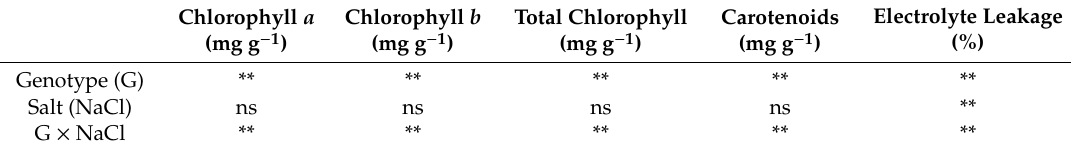
Table 3. Chlorophyll a , b , total carotenoids content, and electrolyte leakage in leaves of seedlings of sixteen Cucumis melo L., six Citrullus vulgaris Schrad, two C. maxima x C. moschata , four Lagenaria